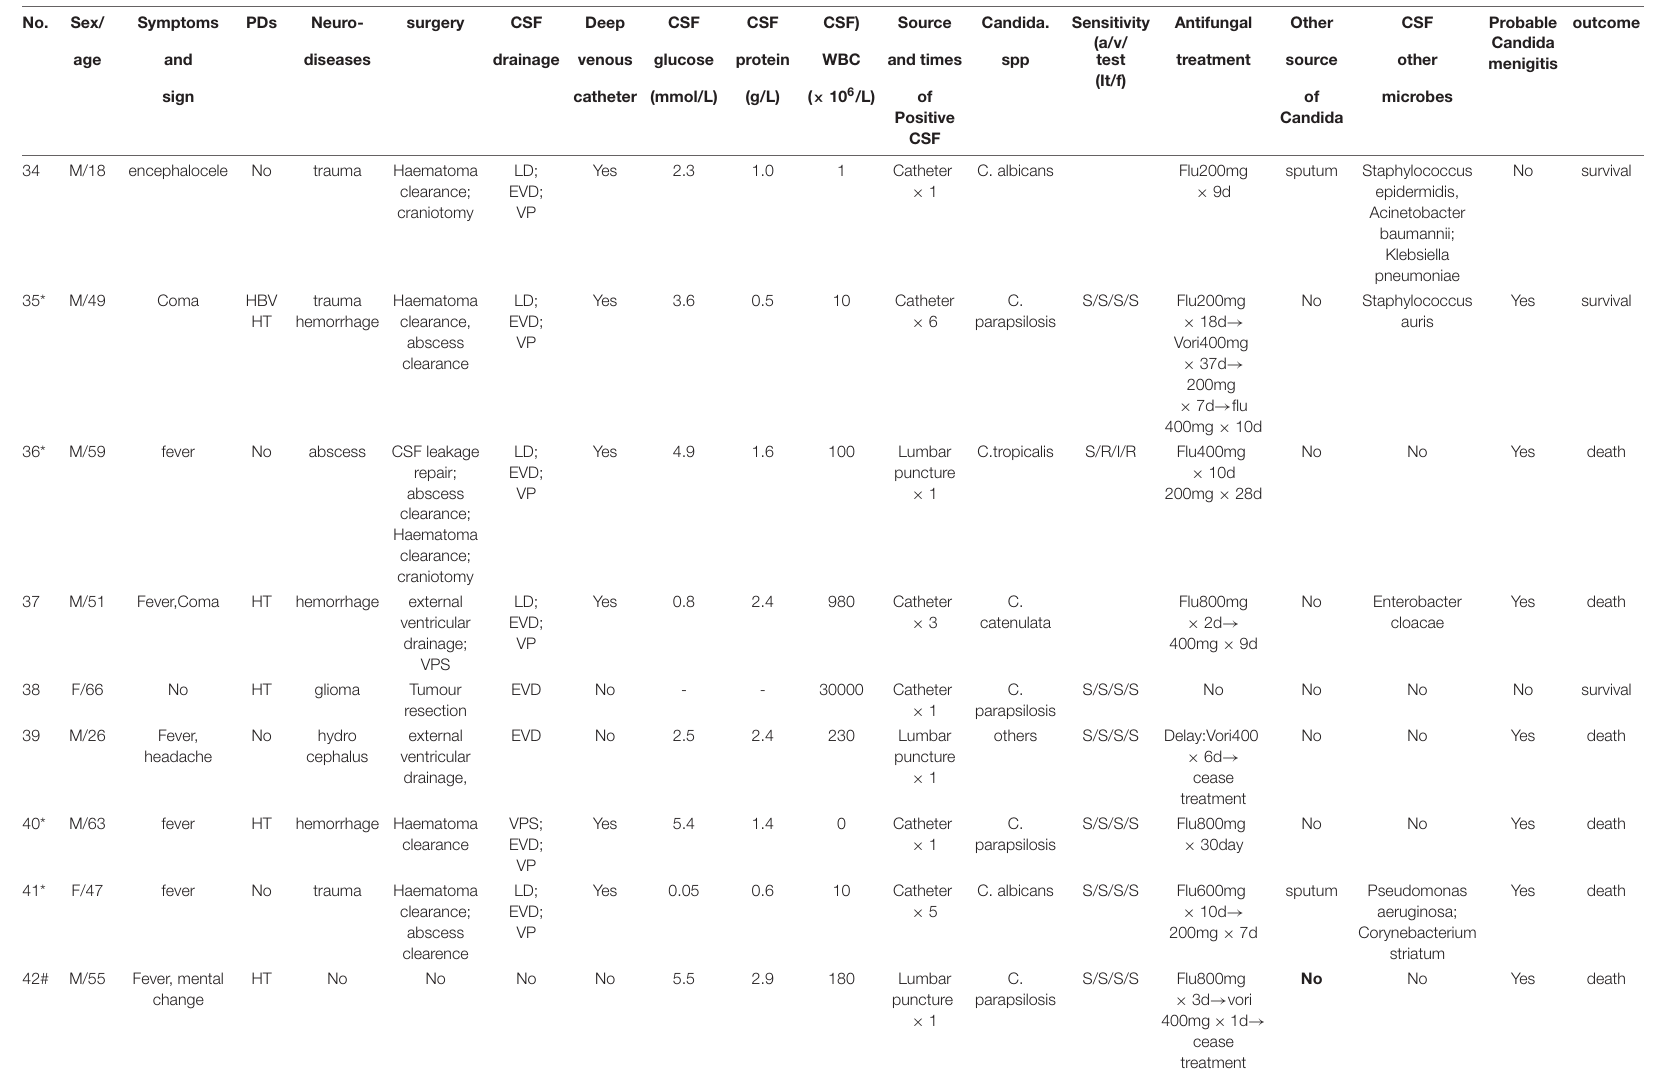
M, male; F, female; PDs, predisposing diseases; HT, hypertension; CKD, chronic kidney disease; SOT, solid organ transplantation; LD, lumbar cistern drainage; EVD, ventricular drainage; VP, ventricular peritoneal shunt; f, fluconazole; v, voriconazole; a, amphotericin B deoxycholate; It, itroconazole; S, sensitivity; I, intermediate; R, resistance; → , more than 2 months. *, patients in intensive care unit; #, DNA sequence of C. parapsilosis was also found in